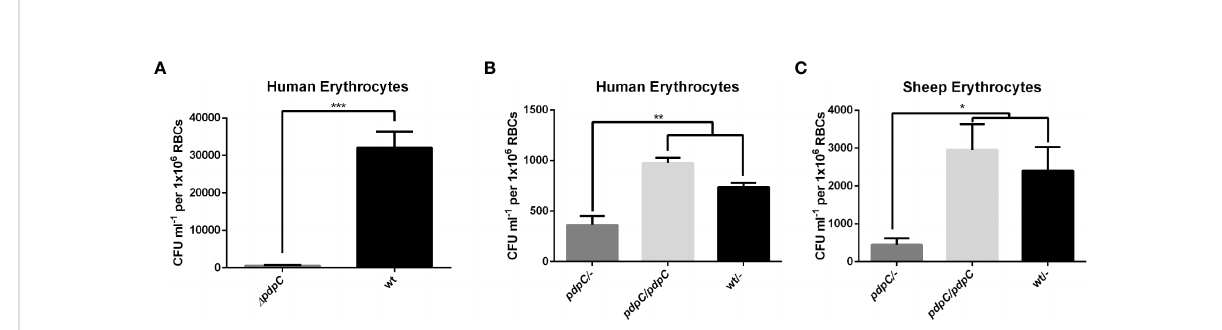
FIGURE 2 PdpC is required for erythrocyte invasion. (A) Human erythrocytes were incubated with either wild type or pdpC -null F. tularensis LVS at an MOI of 50 for 2 hours, cells were then treated for 1 hour with gentamicin to kill extracellular bacteria. Erythrocytes were washed, lysed and intracellular bacteria were enumerated by drip plating. The CFU ml -1 per 1x10 6 Red Blood Cells (RBCs) was signi fi cantly lower for the pdpC -null strain (*** p > 0.0001 determined by unpaired t-test with Welch ’ s correction). (B) Introduction of a copy of pdpC , in trans , restores invasion in human erythrocytes. Erythrocytes were incubated with the indicated strains at an MOI of 12.5 and invasion was tested by gentamicin protection assay as described above. The CFU ml -1 per 1x10 6 Red Blood Cells (RBCs) was signi fi cantly lower for the pdpC -null strain than either the wild type or the pdpC- null strain containing a complementation vector (** p > 0.01 determined by Ordinary 1 way ANOVA with Holm-Sidak's multiple comparisons test). (C) PdpC is required for invasion of Sheep erythrocytes. Sheep erythrocytes were incubated with the indicated strains at an MOI of 100 and invasion was tested by gentamicin protection assay as described above. The CFU ml -1 per 1x10 6 Red Blood Cells (RBCs) was signi fi cantly lower for the pdpC -null strain than either the wild type or the pdpC- null strain containing a complementation vector (* p > 0.05 determined by Ordinary 1 way ANOVA with Holm-Sidak's multiple comparisons test). The averages of at least 3 biological replicates, ± the standard error, are shown and for each biological replicate bacteria incubated without erythrocytes were used as a negative control and this background was subtracted from the